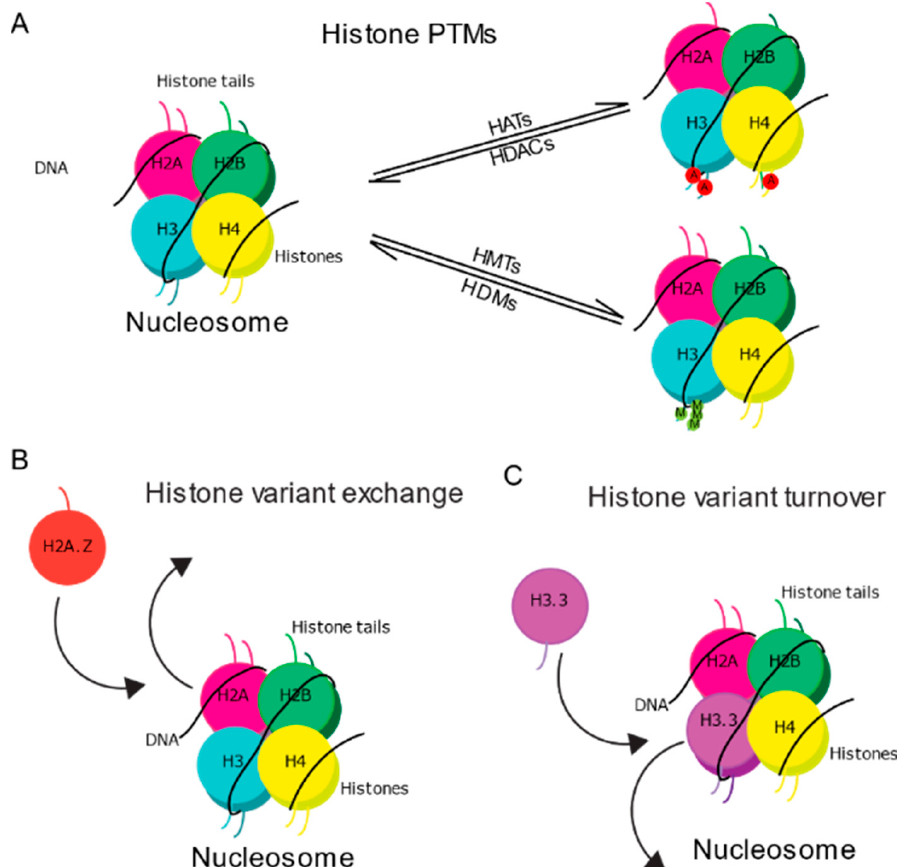
Figure 2. Epigenetic regulation of histones. ( A ) Schematic representation shows organization of DNA around histone octamer. Protruding histone tails can be post-translationally modified by “writer” enzymes, such as histone acetyltransferases (HATs) and histone methyltransferasess (HMTs), and removed by “eraser” enzymes, such as histone deacetylases (HDACs) and histone demethylases (HDMs); Two major mechanisms mediate histone variant functions in chromatin: ( B ) In histone variant exchange, one histone type (H2A in the figure) is removed and replaced with another type (H2A.Z in this example); ( C ) In histone variant turnover, the same histone type is continuously swapping for a new copy of the same variant (figure shows H3.3). Note that histone variant exchange and turnover are not limited to the histone types depicted in the images, as each process can occur with each histone. PTM: post-translational modifications.